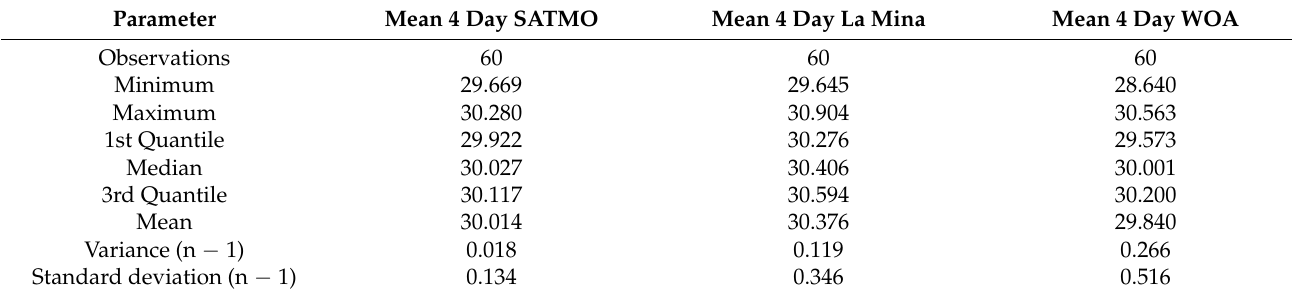
Table 5. Descriptive statistics for SATMO, WOA and in situ at La Mina.